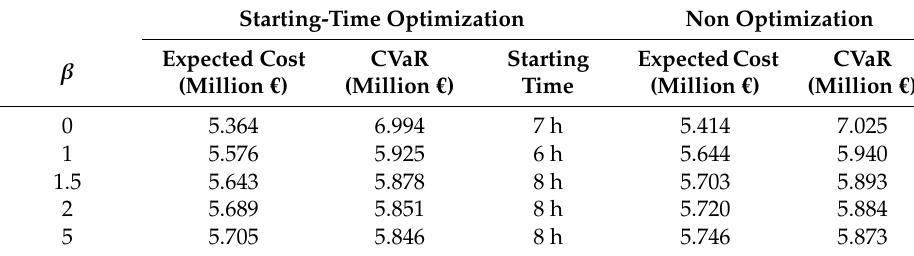
Table 10. Total procurement on valley, shoulder and peak hours for different risk aversion factors with and without starting-time optimization.